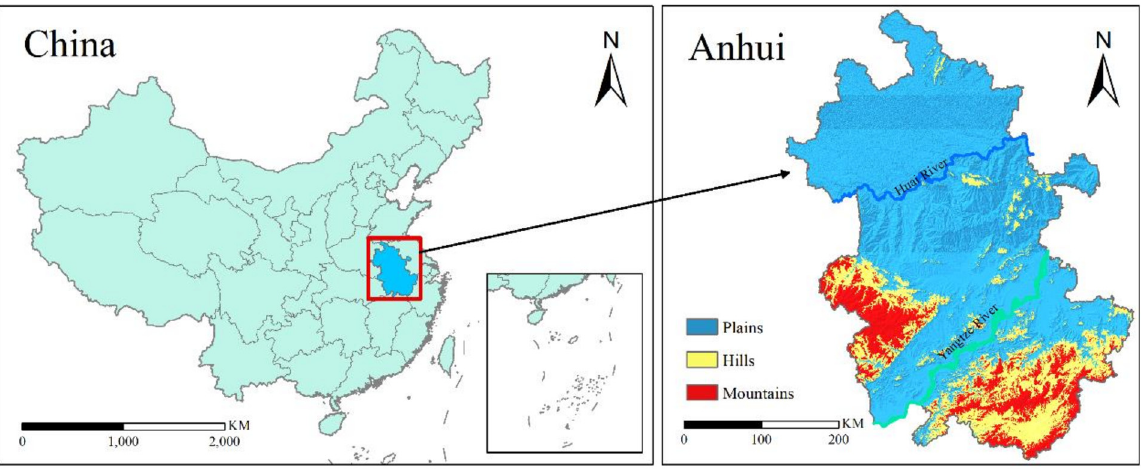
Figure 1. Study area: Anhui Province in